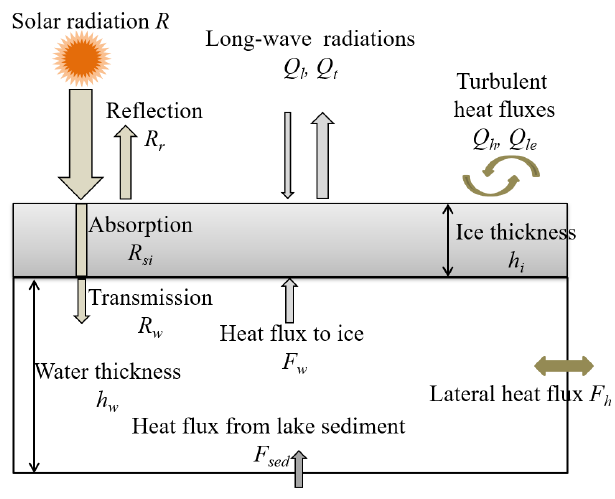
Figure 3. Heat budget components of the water column under the ice (modified from Huang et al., 2019b). Table 2. Uncertainties in calculation of heat